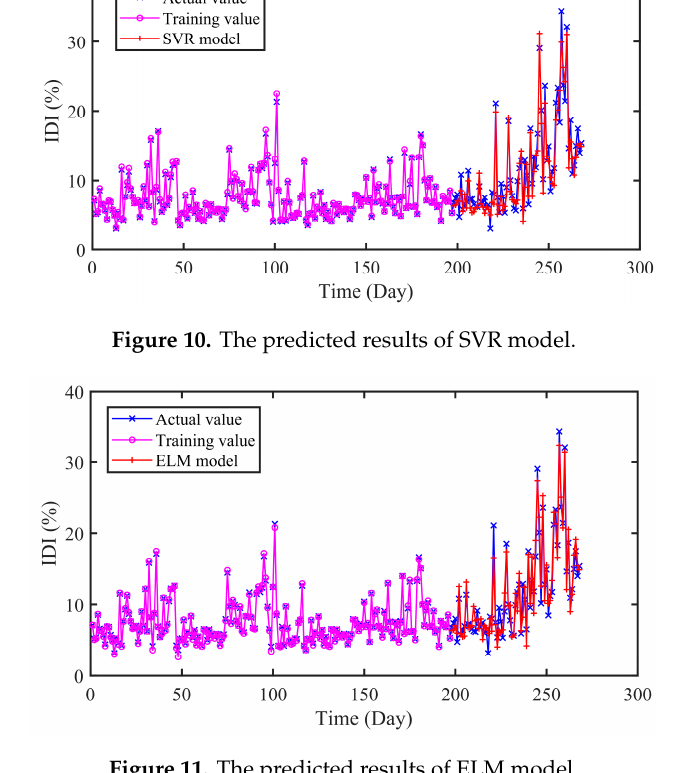
Figure 11. The predicted results of ELM model. Table 5. The performance of di ff erent models in terms of RMSE, MAE, MAPE and